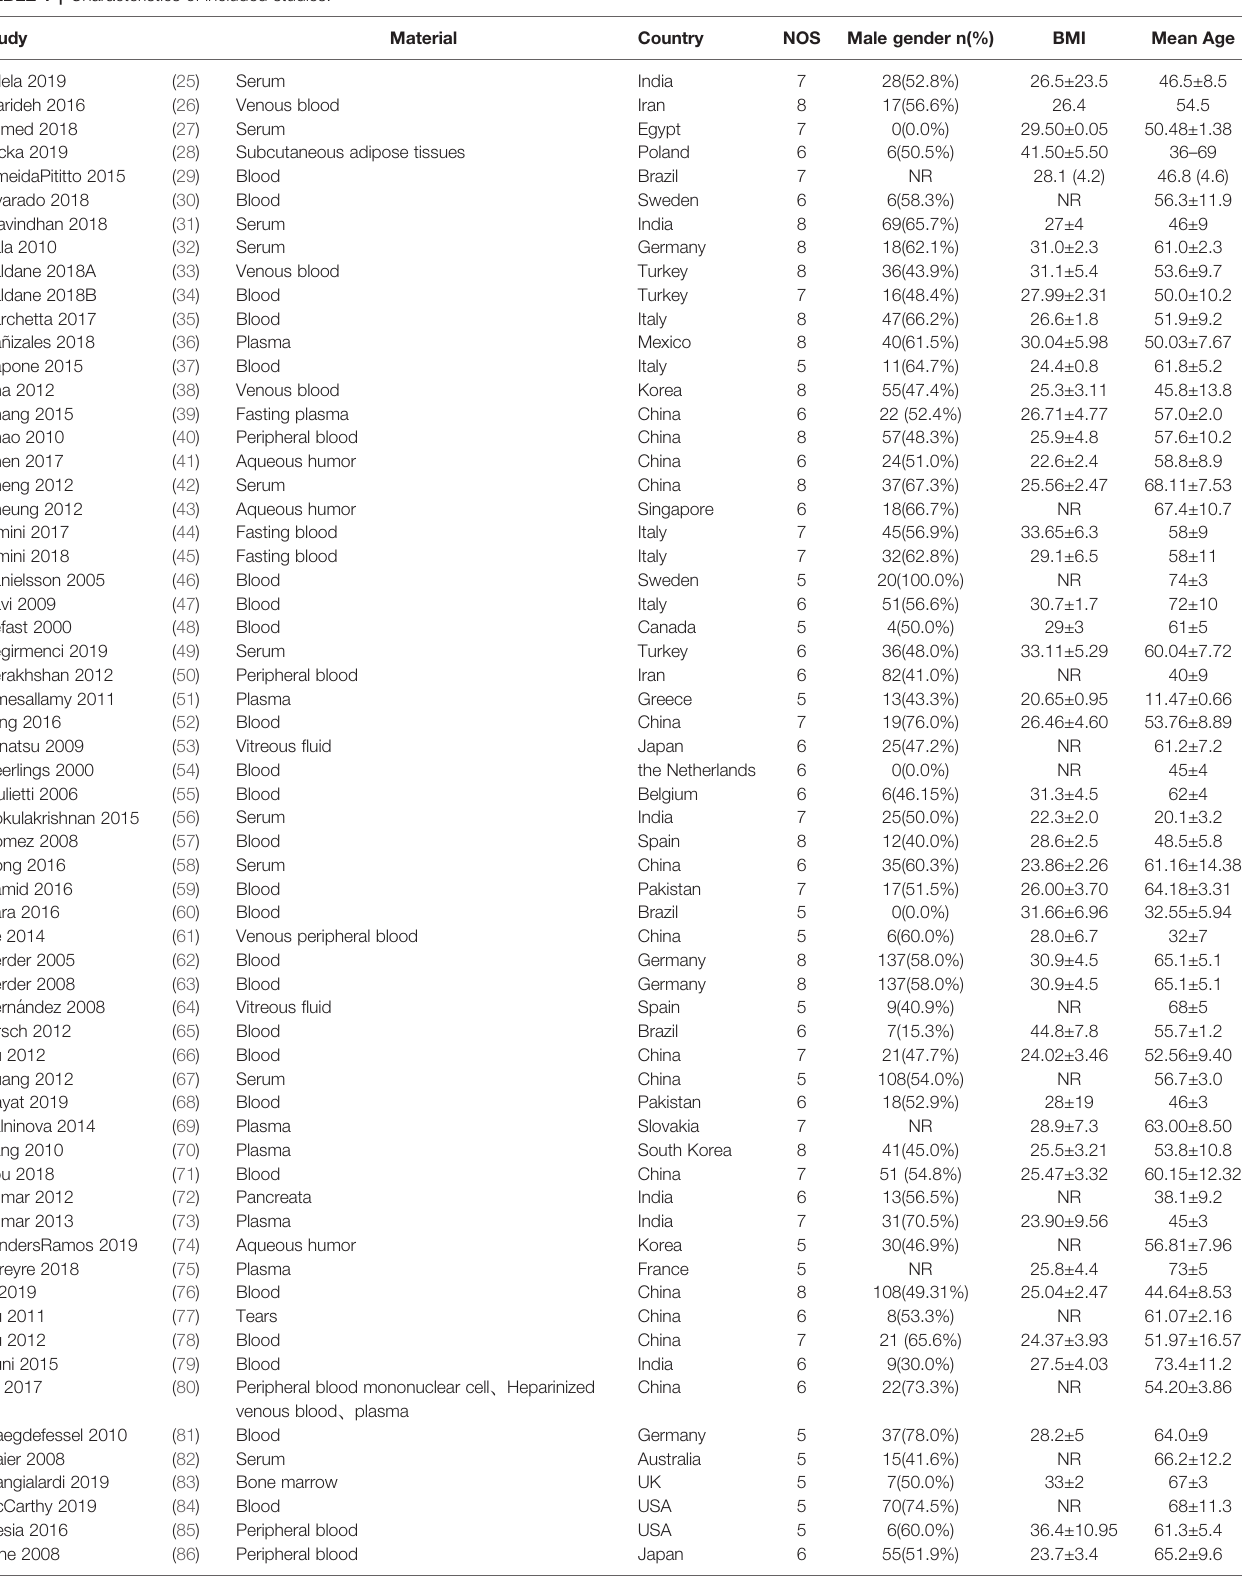
TABLE 1 | Characteristics of included